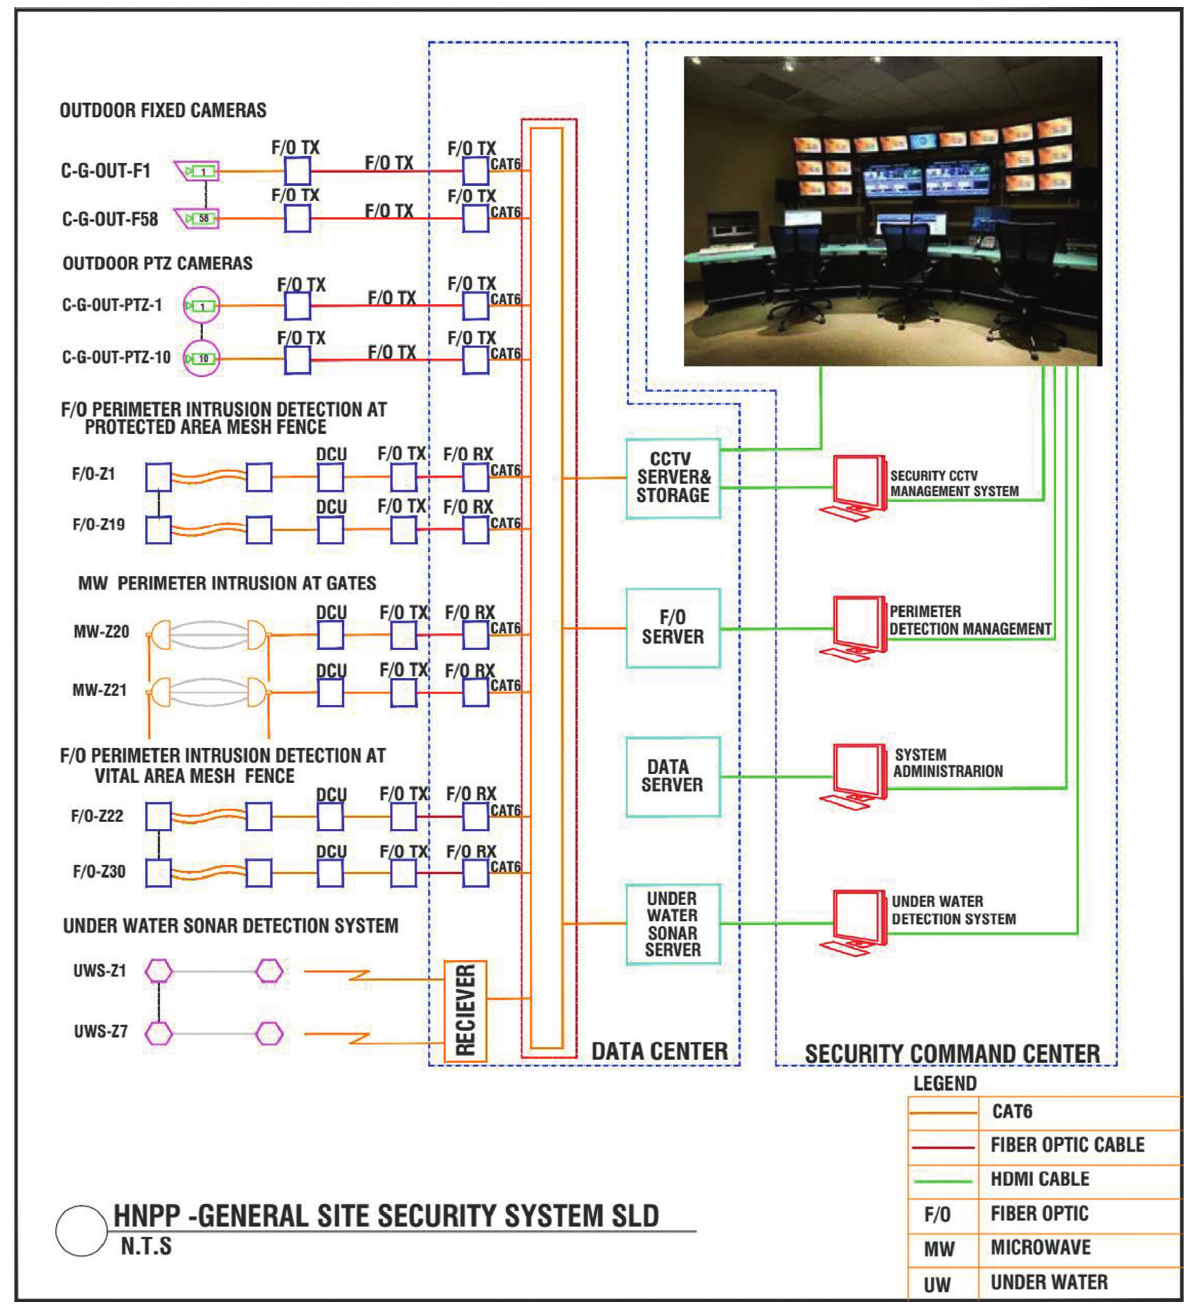
Figure 4: Security system single-line diagram for the NPP boundaries. Cameras and sensors are transmitting their signal to data collection units and via F/O cable and data network to servers in data centers passing to the SCC, alarming PCs and video